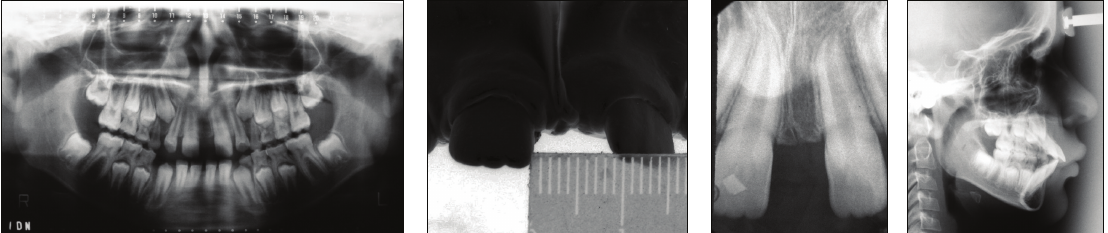
Figure 2: Pretreatment